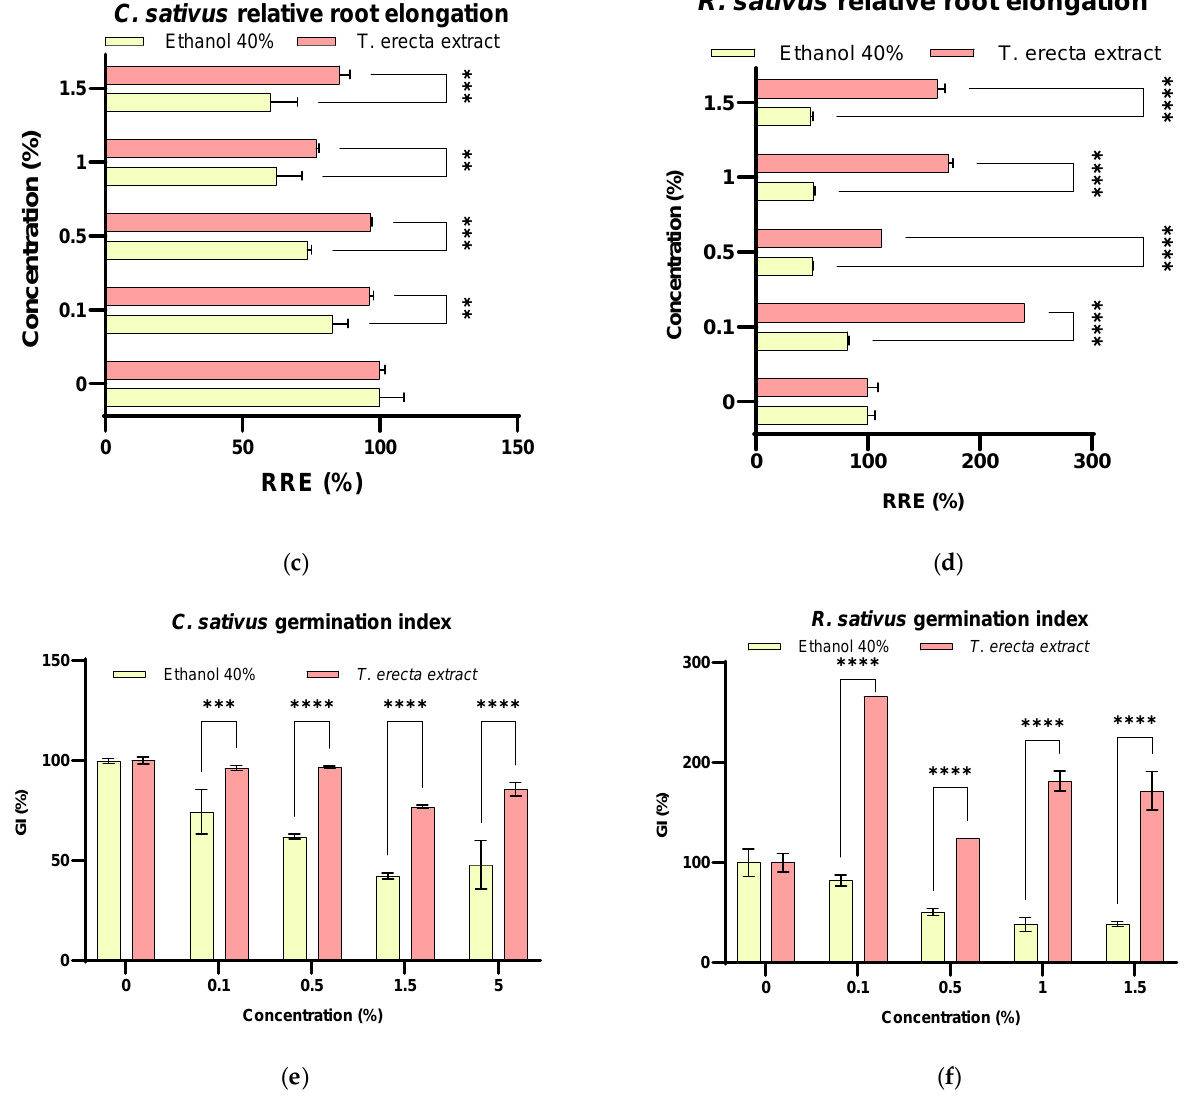
Figure 3. Relative seed germination (%) (( a )— C. sativus , ( b )— R. sativus ), relative root elongation (%) (( c )— C. sativus , ( d )— R. sativus ) and germination index (%) (( e )— C. sativus , ( f )— R. sativus ) for T. erecta extract and the corresponding concentration of solvent treatments (* p < 0.05, ** p < 0.01, *** p < 0.001, **** p < 0.0001).